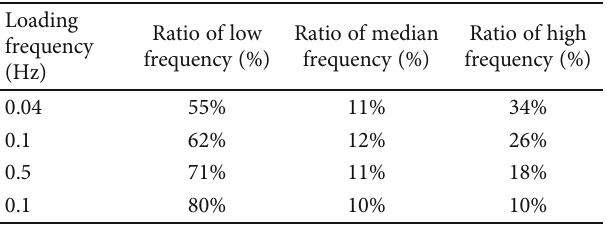
Figure 9: The main frequency characteristics of granite samples during the whole deformation process, during sample failure for granite with inclined fl aw of 20 ° , 50 ° , and 70 ° , respectively. (a – d) The dynamic loading frequency is 0.04, 0.1, 0.5, and 1.0, respectively. Table 3: Percentage of the low-, medium-, and high-frequency AE signals during rock